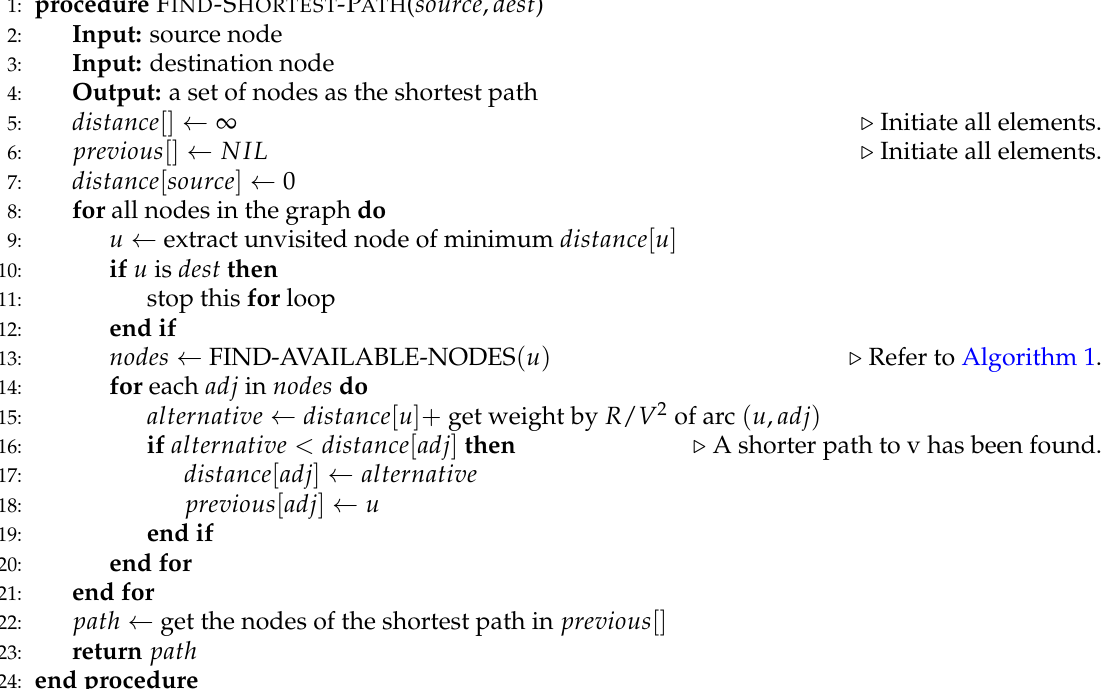
Algorithm 2 Find the shortest path from a source node to a destination node based on a weighted graph and the Arc Dynamic Direction Matrix.